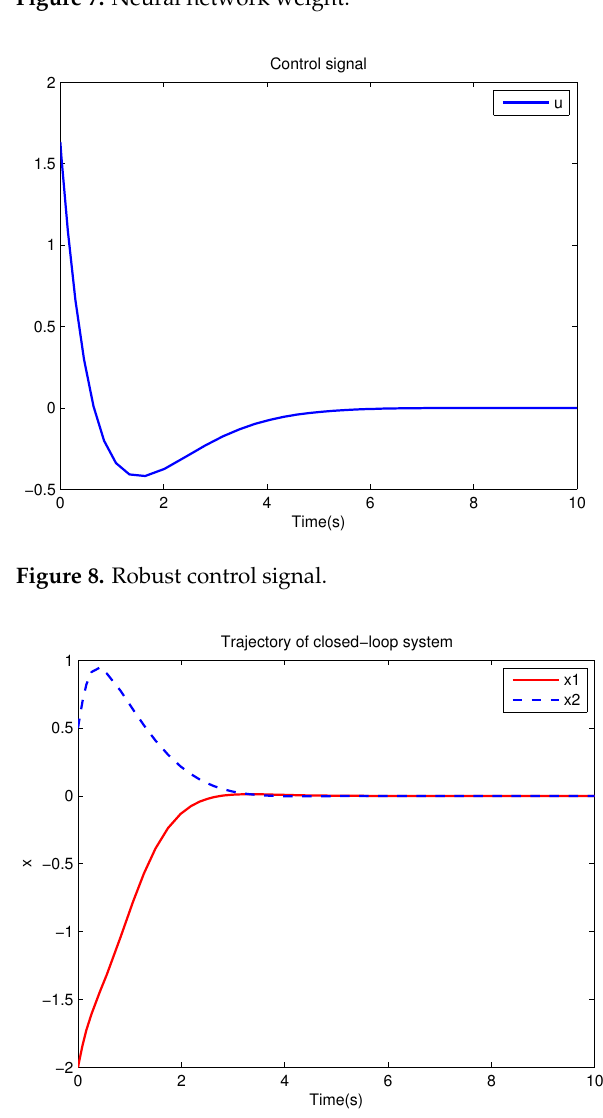
Figure 7. Neural network weight.